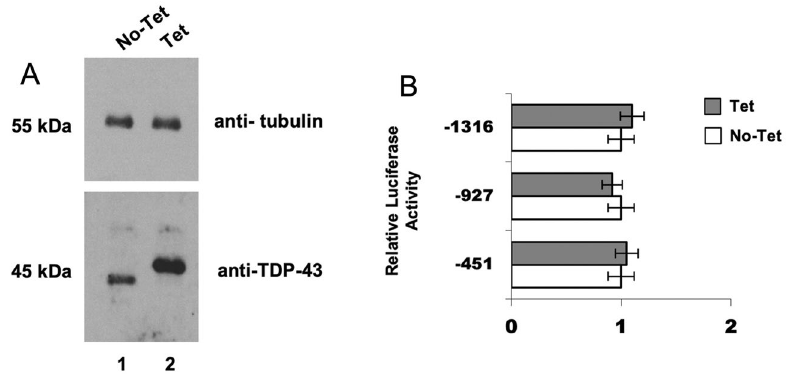
Figure 7. Effects of TDP-43 overexpression on TARDBP promoter activity. ( A ) Immunoblot analysis of TDP-43 expression after 48 h-Tetracycline induction (Tet) of the HEK293-Flp-In-TDP-43 wild type stable cell line. Both endogenous (lane 1) and Flag-tagged (lane 2) proteins were visualized using anti-TDP-43 polyclonal antibody (ProteinTech). As expected, overexpression of Flag-tagged wild-type TDP-43 silenced the expression of the endogenous protein by triggering autoregulatory loop. Beta-Tubulin was used as loading control to normalize the levels of detected proteins. ( B ) Effects of TDP-43 overexpression on TARDBP promoter activity. The luciferase activity of three different constructs (1316, 927 and 451) transfected in the HEK293-Flp-In- TDP-43 wild type stable cell line was assayed without (No-Tet) or after (Tet) Tetracycline induction for 48 h. No statistically significant differences were found. Data are mean (± SD) of three independent assays. Significance values refer to comparisons against control transfections (No-Tet) by using one way ANOVA with Tukey